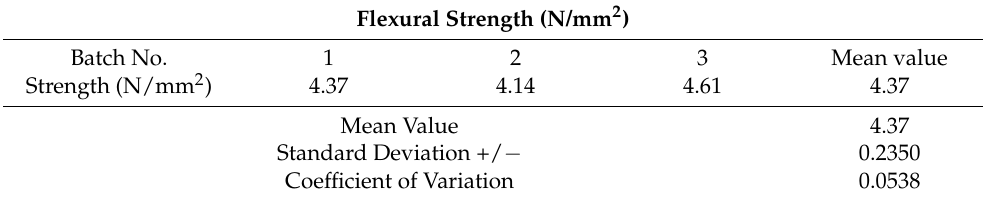
Table 6. Results of the flexural strength test for the reference gypsum mortar (G/W ratio = 1.86).